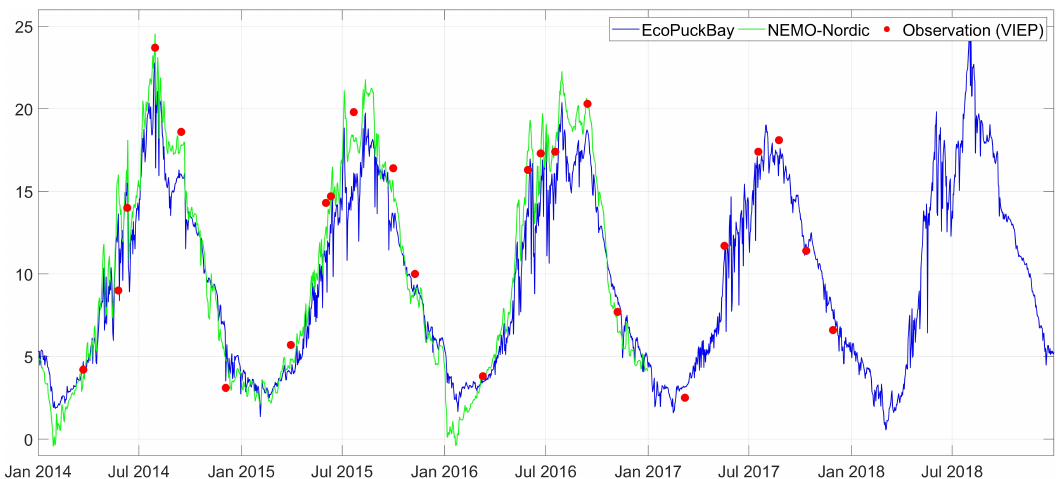
Figure A3. Time series of surface water temperature on station T12 compared with VIEP observations and NEMO-Nordic model.